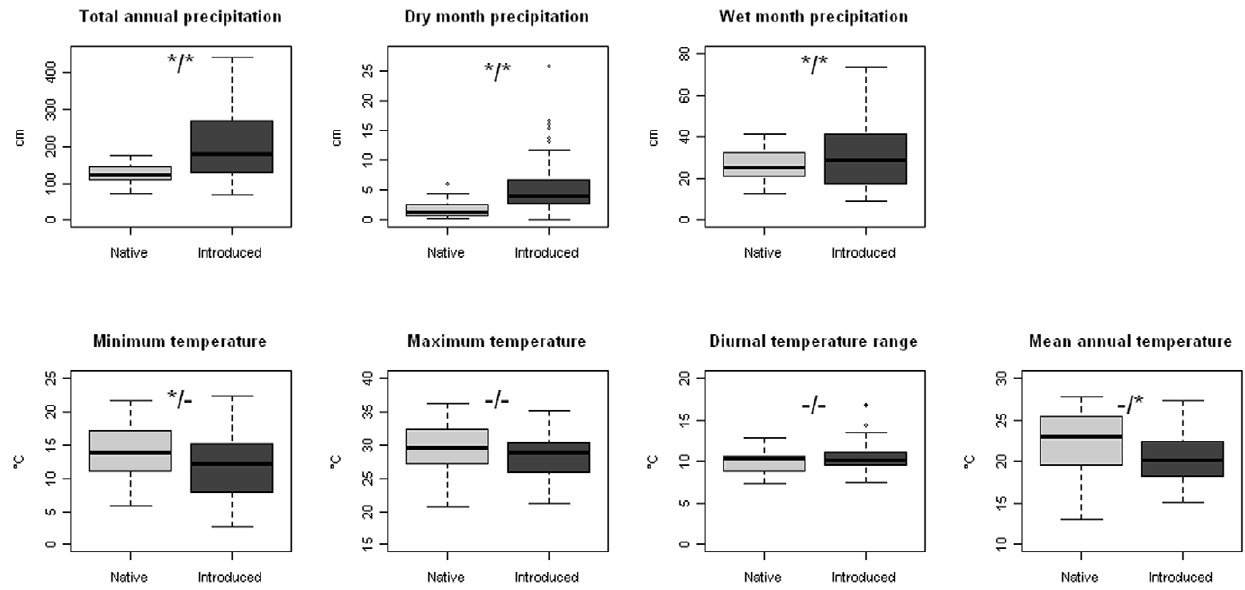
Figure 1. Example climatic parameters of Impatienswalleriana across localities sampled from the native and introduced ranges. * indicates a significant difference (mean/breadth); - indicates nonsignificant differences. Shown are the median (line) 6 interquartile range (boxes) 6 1.5 times the interquartile range (whiskers).